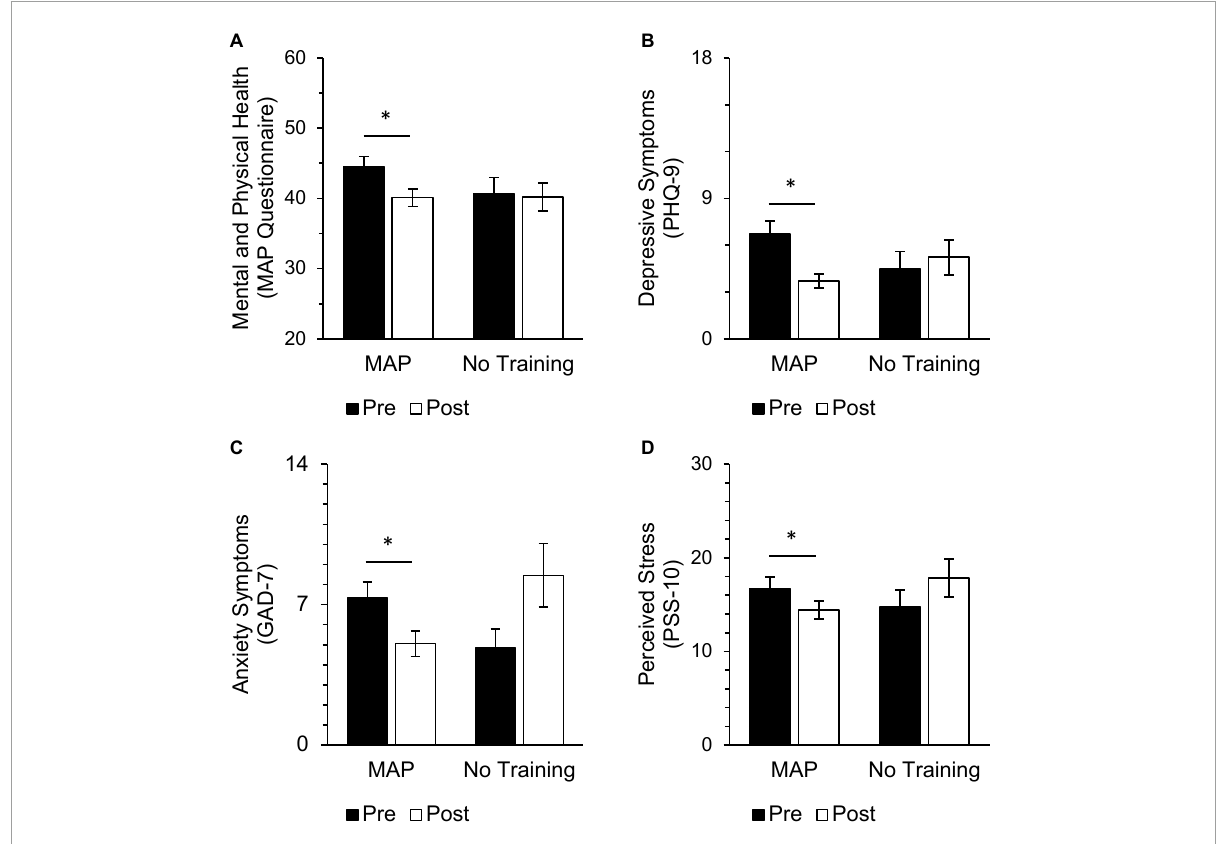
FIGURE3 In the MAP group, post-intervention scores were significantly improved from pre-intervention scores on measures of trauma and mood [ (A) MAP Health Questionnaire], depressive symptoms [ (B) PHQ-9], anxiety symptoms [ (C) GAD-7], and perceived stress [ (D) PSS-10]. There were no differences between pre-intervention and post-intervention scores on these same measures in the No Training group and no differences between groups at either timepoint. Asterisks indicate significant adjusted p -values. Scores range from 20 to 80 on the MAP Health Questionnaire, 0 to 27 on the PHQ-9, 0 to 21 on the GAD-7, and 0 to 40 on the